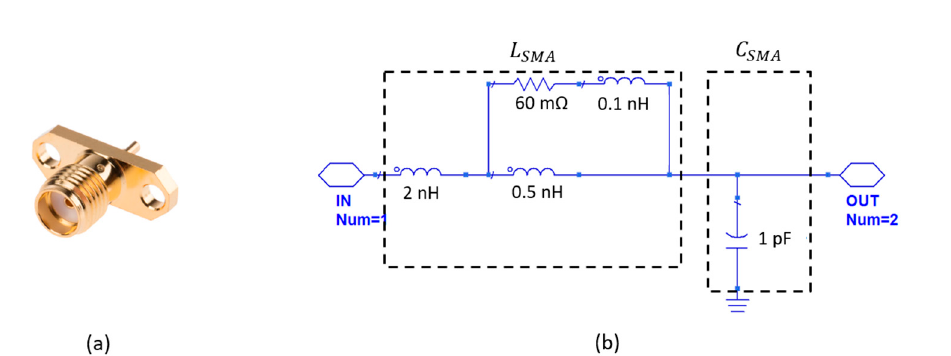
Figure 4. SMA connector: ( a ) presentation of the connector; ( b ) proposed equivalent circuit.